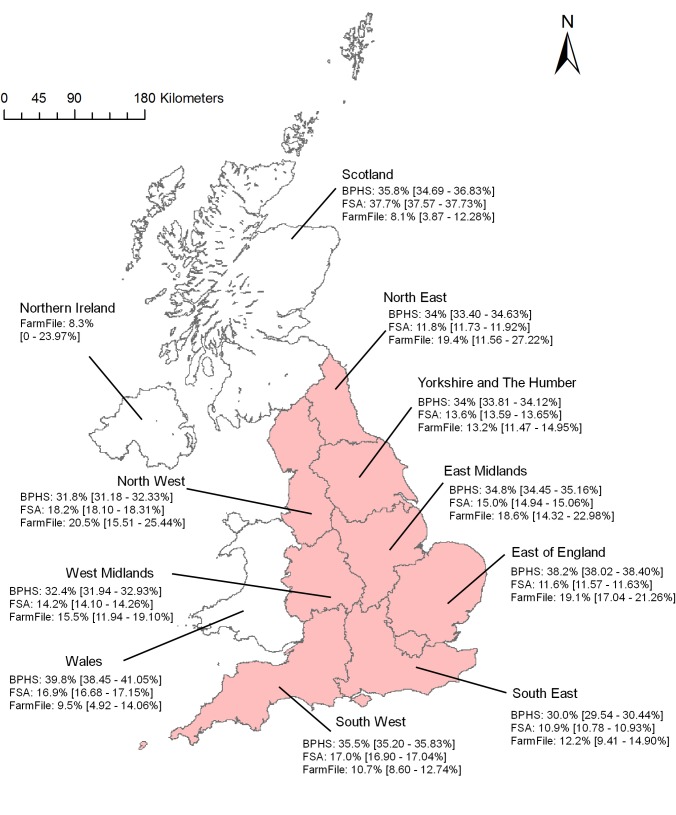
Prevalence of respiratory lesions by UK NUTS1 during the studied period for the three datasets (FSA, BPHS and FarmFile).England is indicated by the regions shown in pink. The 95% confidence interval for the prevalence is within brackets.